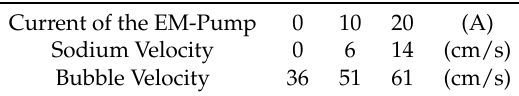
Table 1. Sodium and estimated bubble